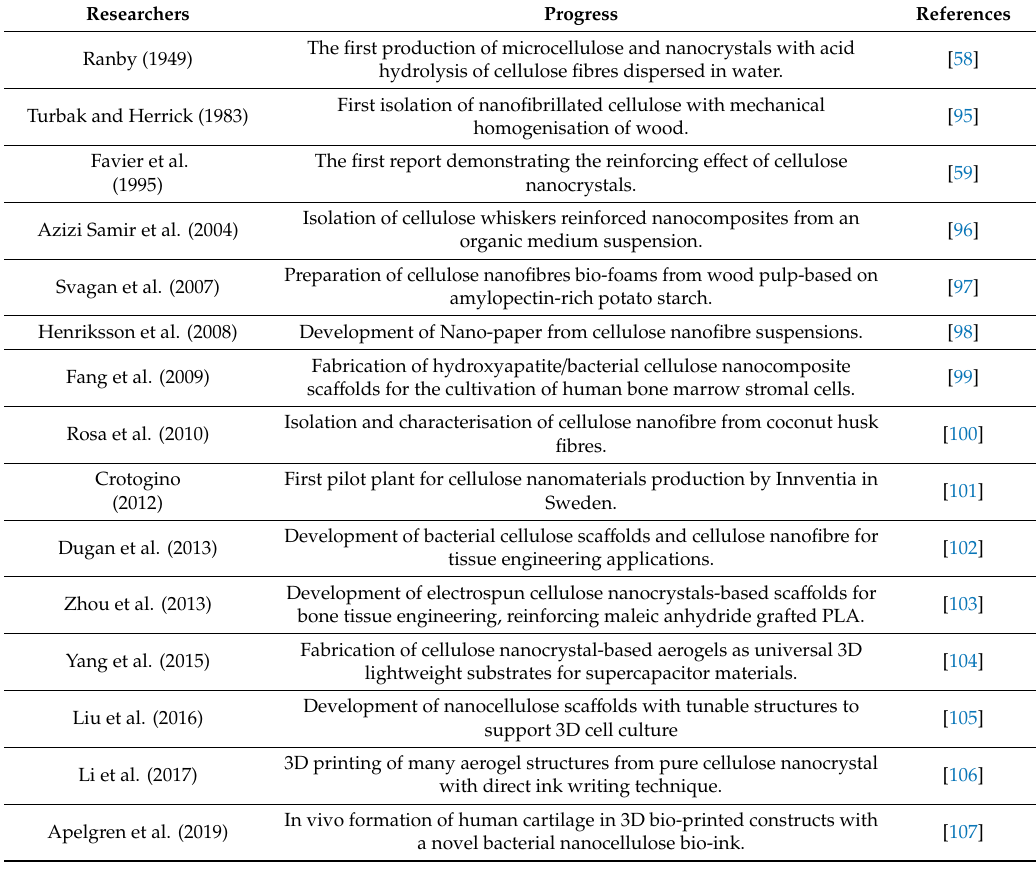
Chronological summary of the evolutionary research trend on nanocellulose-based sca ff old